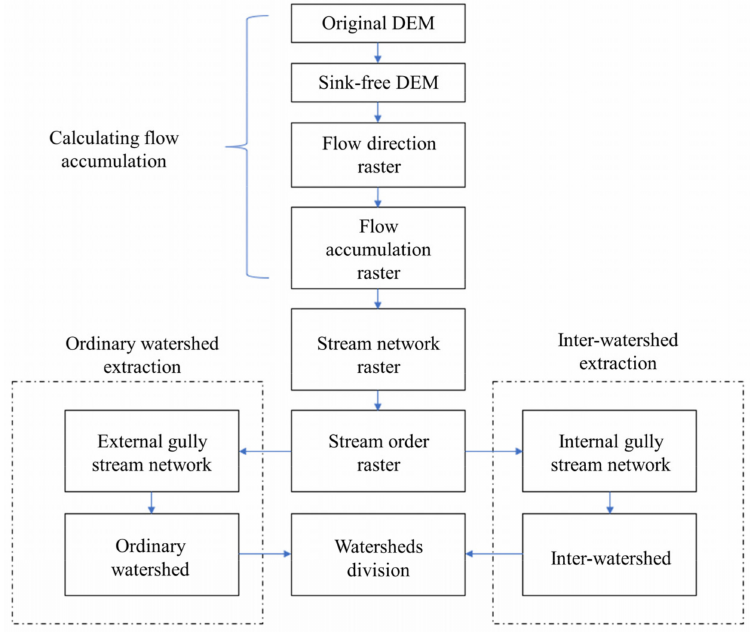
Figure 4. The process for watershed